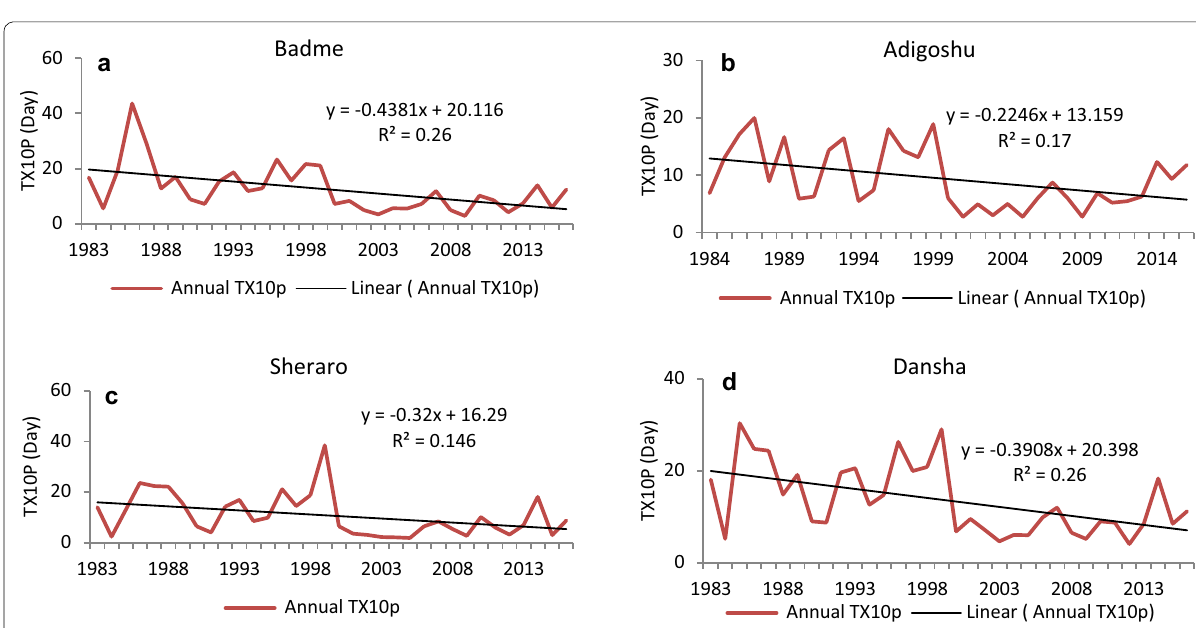
Fig. 7 Annual cool days (TX10P) of different stations at a Badme, b Adigoshu, c Sheraro, d